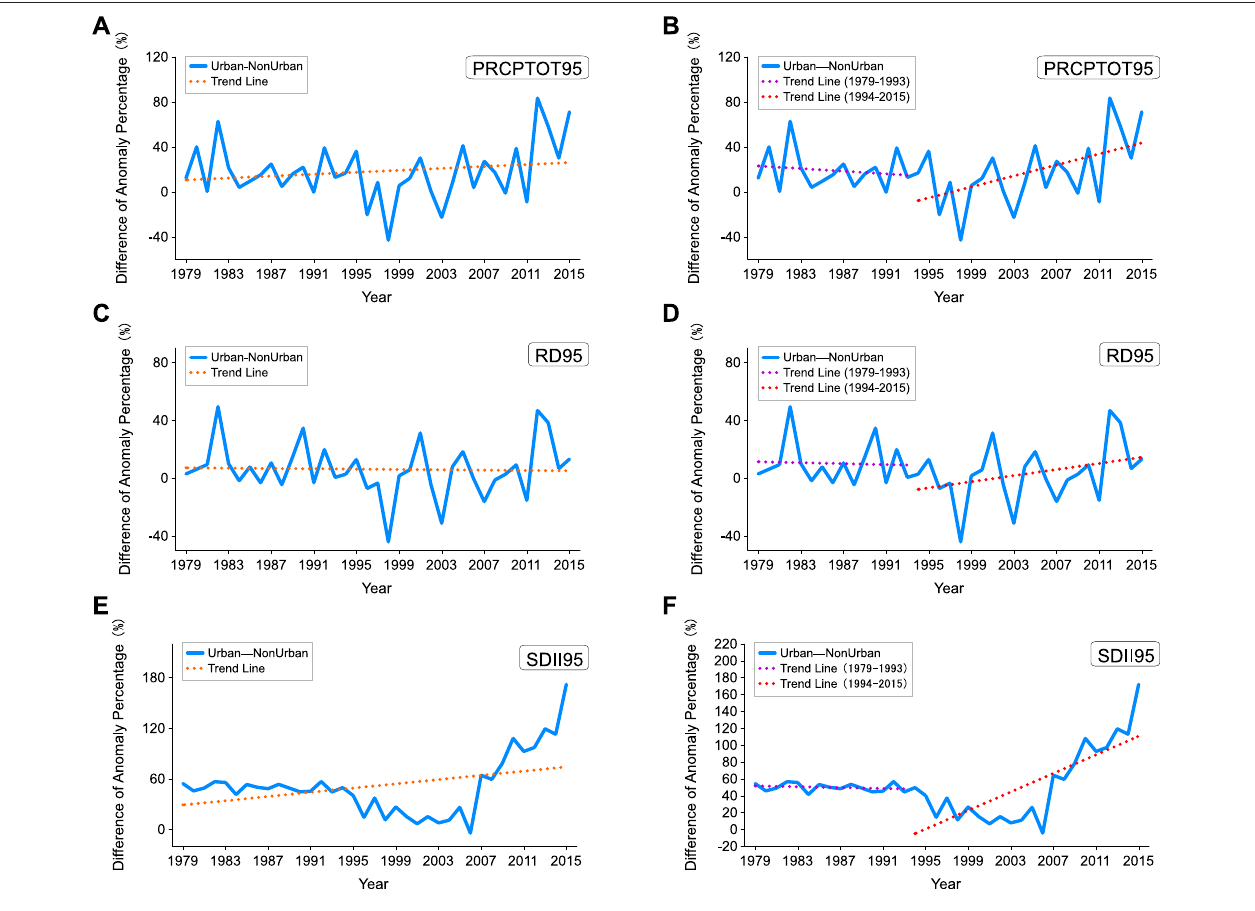
FIGURE 6 | Precipitation anomaly percentage difference (PAP-DIFF) trends of the annual average PRCPTOT95 (A,B) , RD95 (C,D) , and SDII95 (E,F) between urban and non-urban areasin theSichuan – Chongqingarea.PRCPTOT95 istheextreme precipitationamount,RD95istheextreme precipitationfrequency,and SDII95 is the extreme precipitation intensity. Only grid points that passed the Mann − Kendall trend test at the 90% con fi dence level were included in the PAP-DIFF trends.